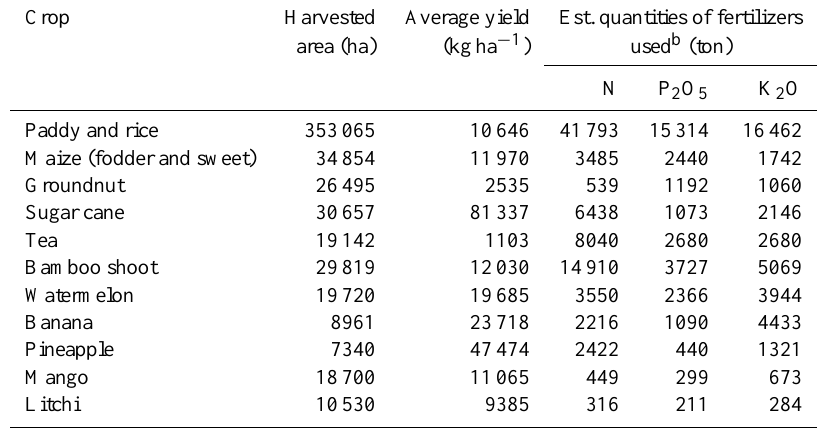
Table 1. Crop area and yield and estimated quantities of fertilizers used in Taiwan (from FAO, 2002) a .